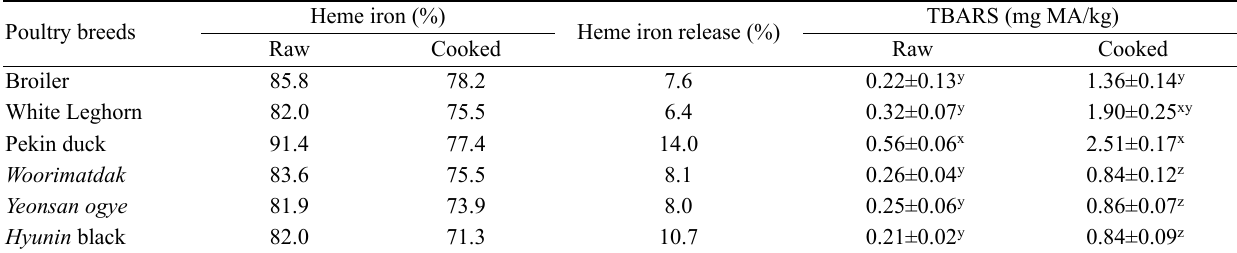
Table 6. Percentage of iron release and TBARS value of raw and cooked thigh meat of different breeds of poultry Heme iron (%) Poultry breeds Heme iron release